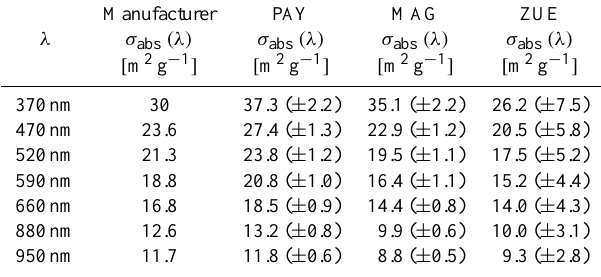
Table 2. Wavelength-dependent aerosol light absorption cross sec- tions used in this study. Values were determined from the linear regression of b abs (λ) against the concentration of elemental carbon in PM 2 . 5 (for MAG in PM 10 ). Note that the values for light absorp- tion cross sections depend on the method used for determination of EC mass